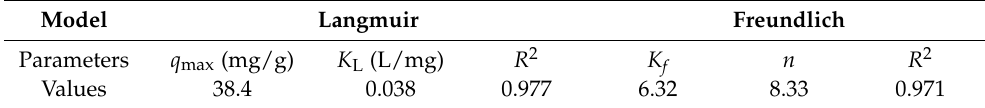
Table 1. Adsorption isotherm parameters for Cr(VI) adsorption on 0.6 g/100 mL Fe(0)@AC material.